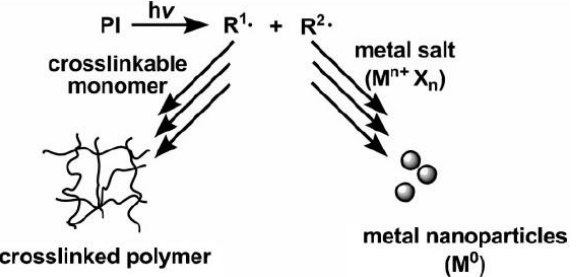
Figure 10. In situ synthesis of polymer network containing metal nanoparticles (NPs) by light- induced processes. Reprinted with permission. Copyright 2009, Wiley [65].